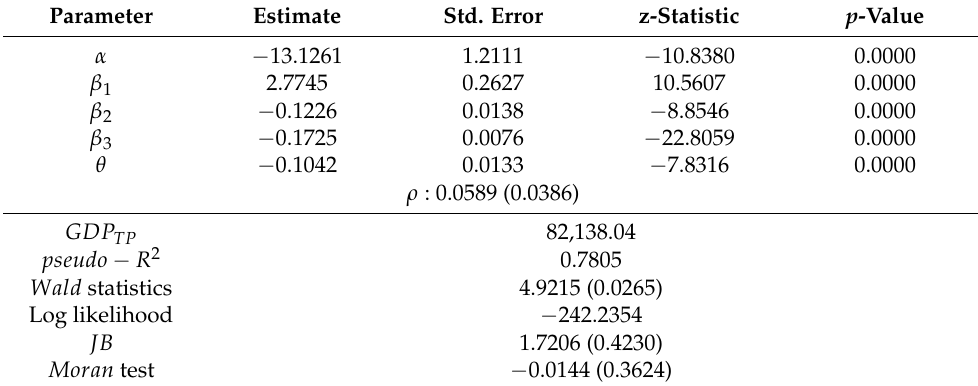
Table 3. The results of estimation and verification of the spatio-temporal Durbin model for the squared Kuznets curve.